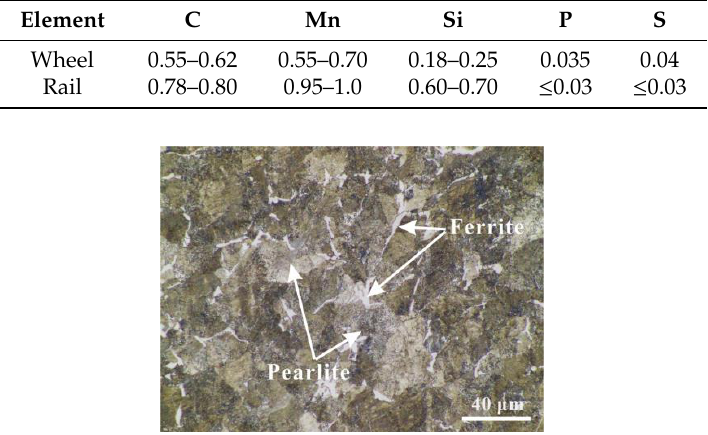
Figure 2. Microstructure of as-received wheel material. Table 1. Chemical composition of wheel/rail rollers (wt%).